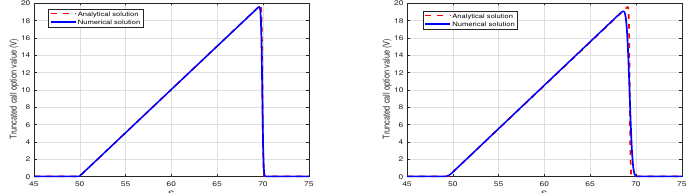
Figure 9. Numerical solution provided by the MMADE scheme with parameter values r = 0.01 ( right ) and parameter r = 0.001 ( left ). Other parameter values σ = 0.001, a = − 1250, T = 1, U = 70, K = 50, L = 30, S max = 140, ∆ S = 0.05, ∆ t = 10 − 3 . If one of conditions (29) or (30) is violated, then the numerical solution may have low